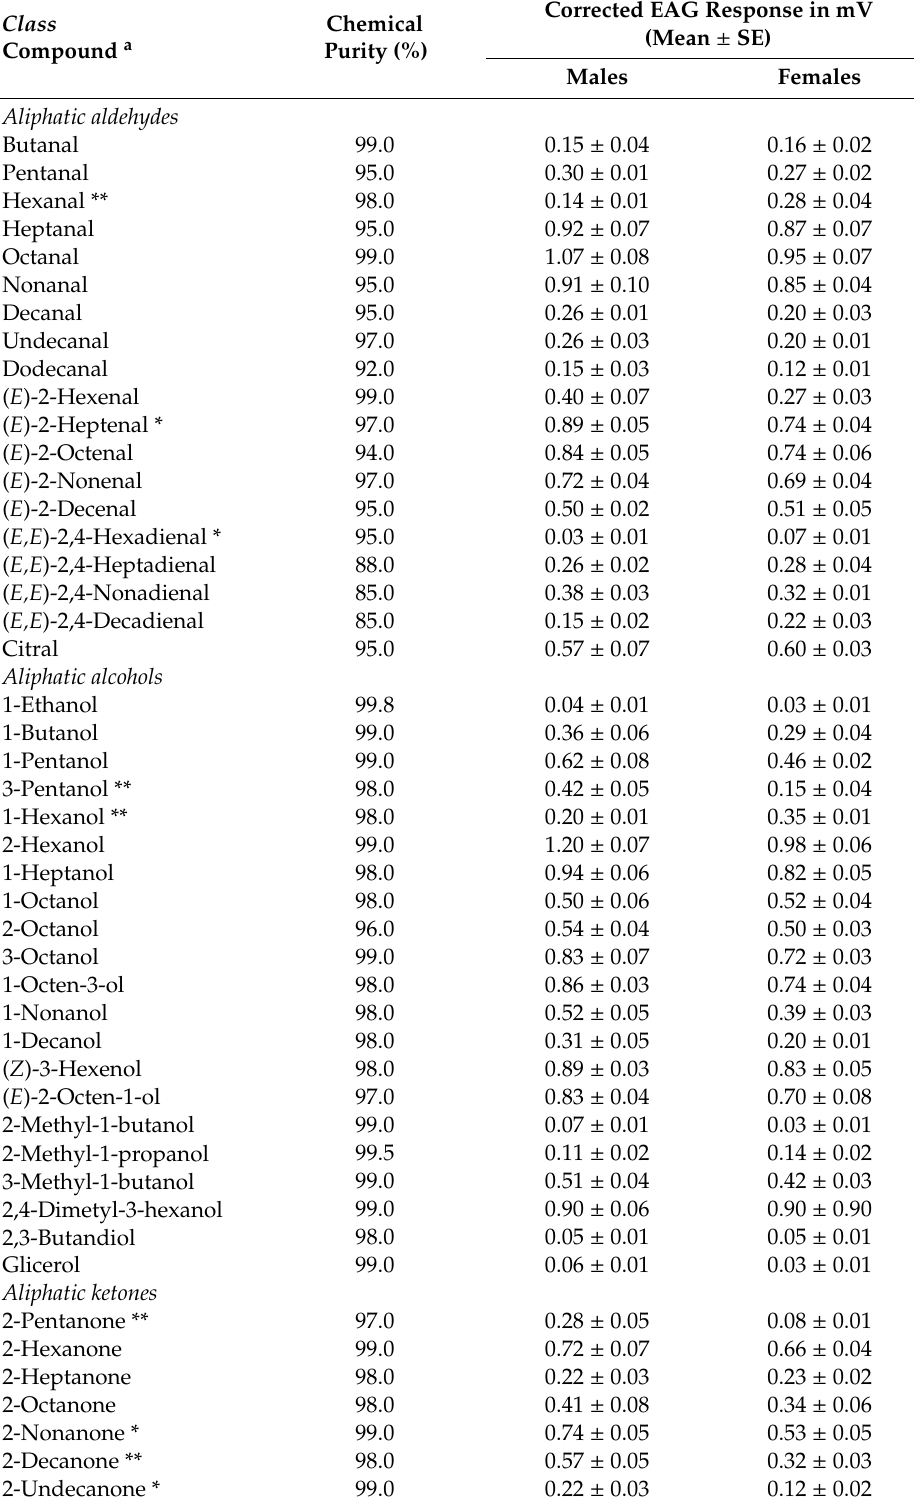
Table 1. EAG responses of male and female A. bungii distal flagellomeres (seventh to ninth) to 90 volatile organic compounds